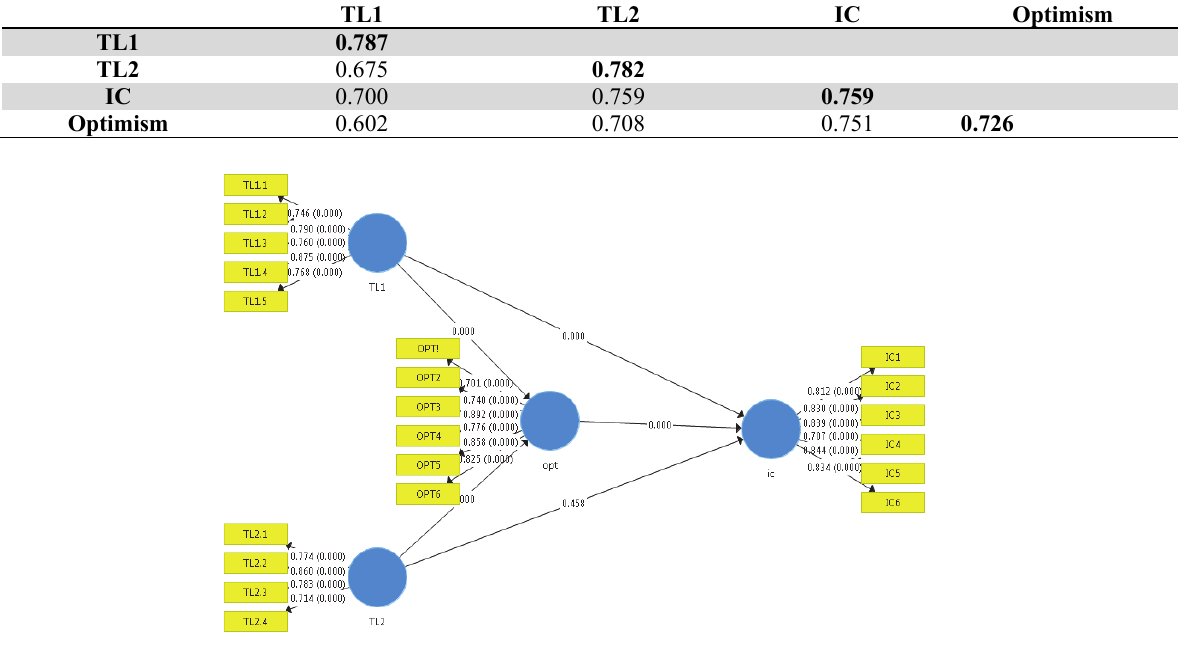
Fig. 2. Measurement Model (Outer